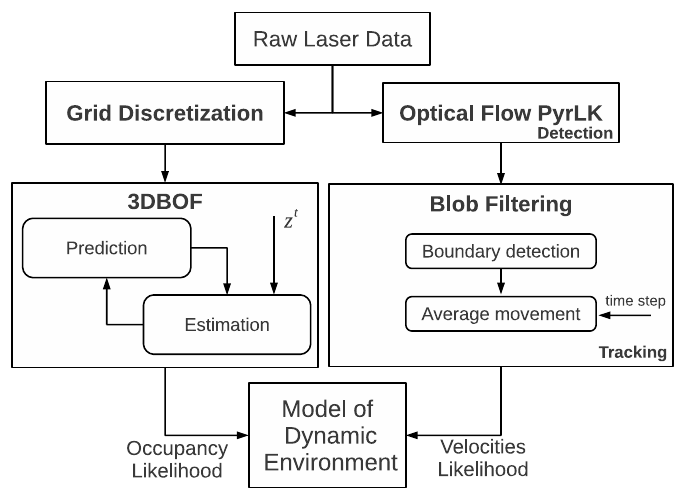
Figure 2. Probabilistic model of the dynamic environment.